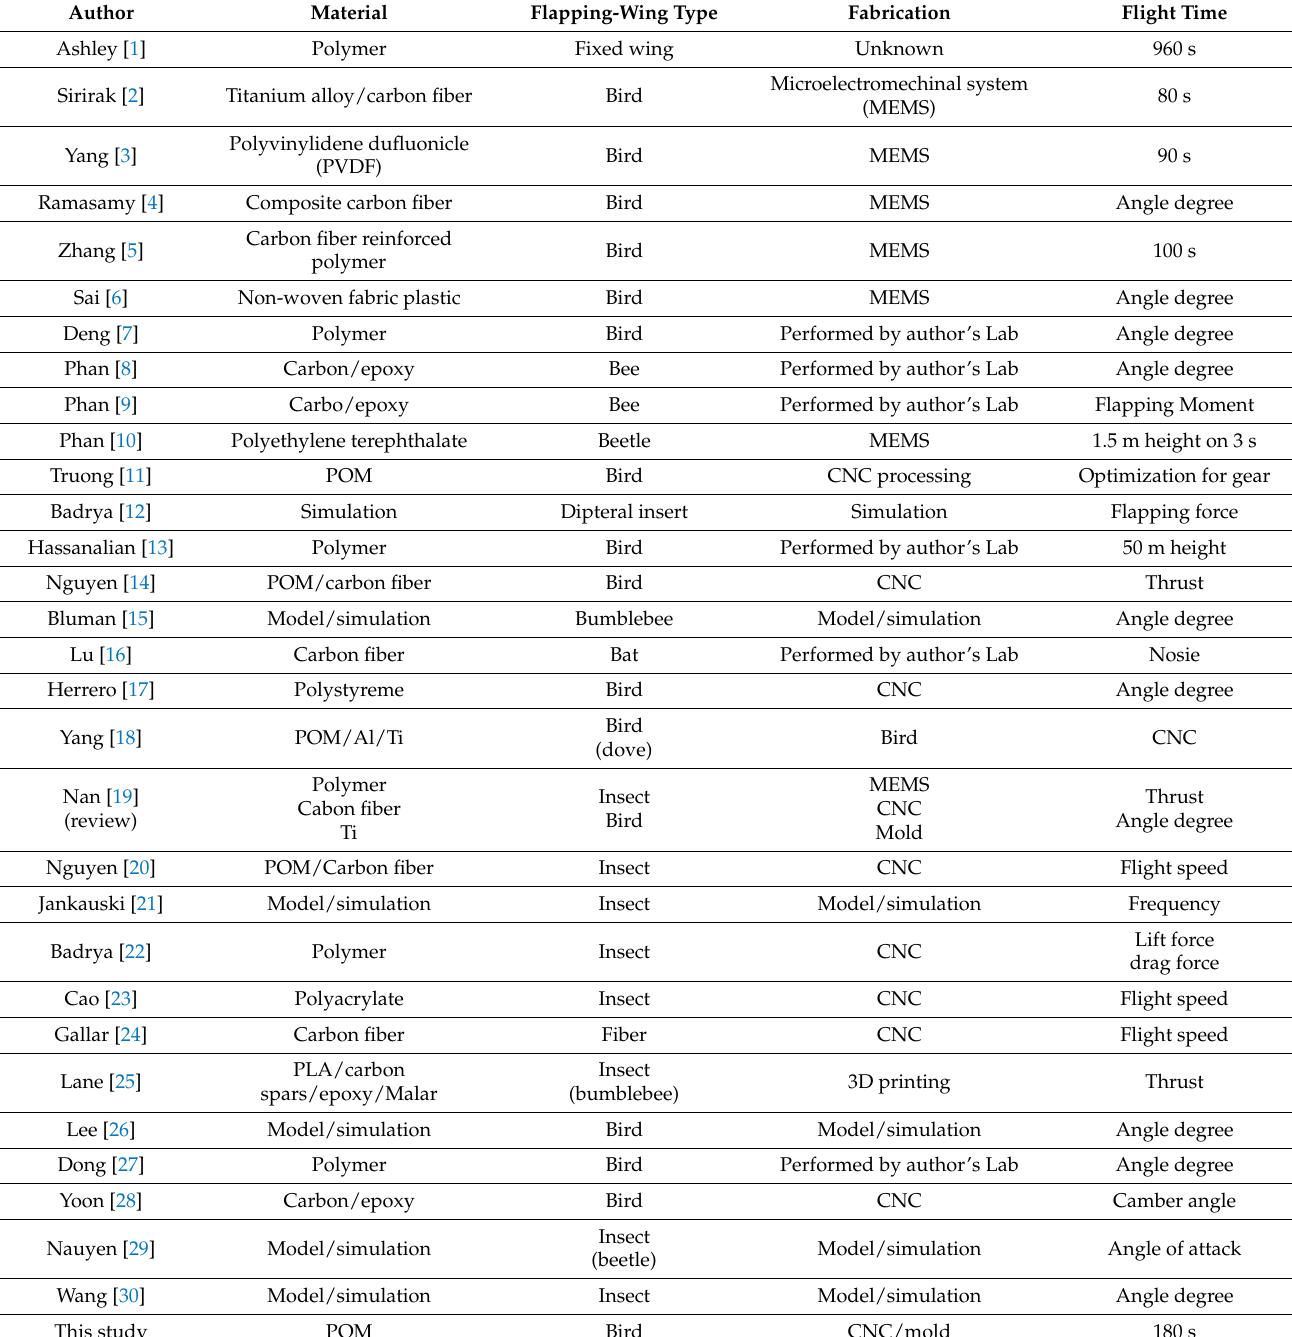
Table 1. References for flapping-wing micro-aerial